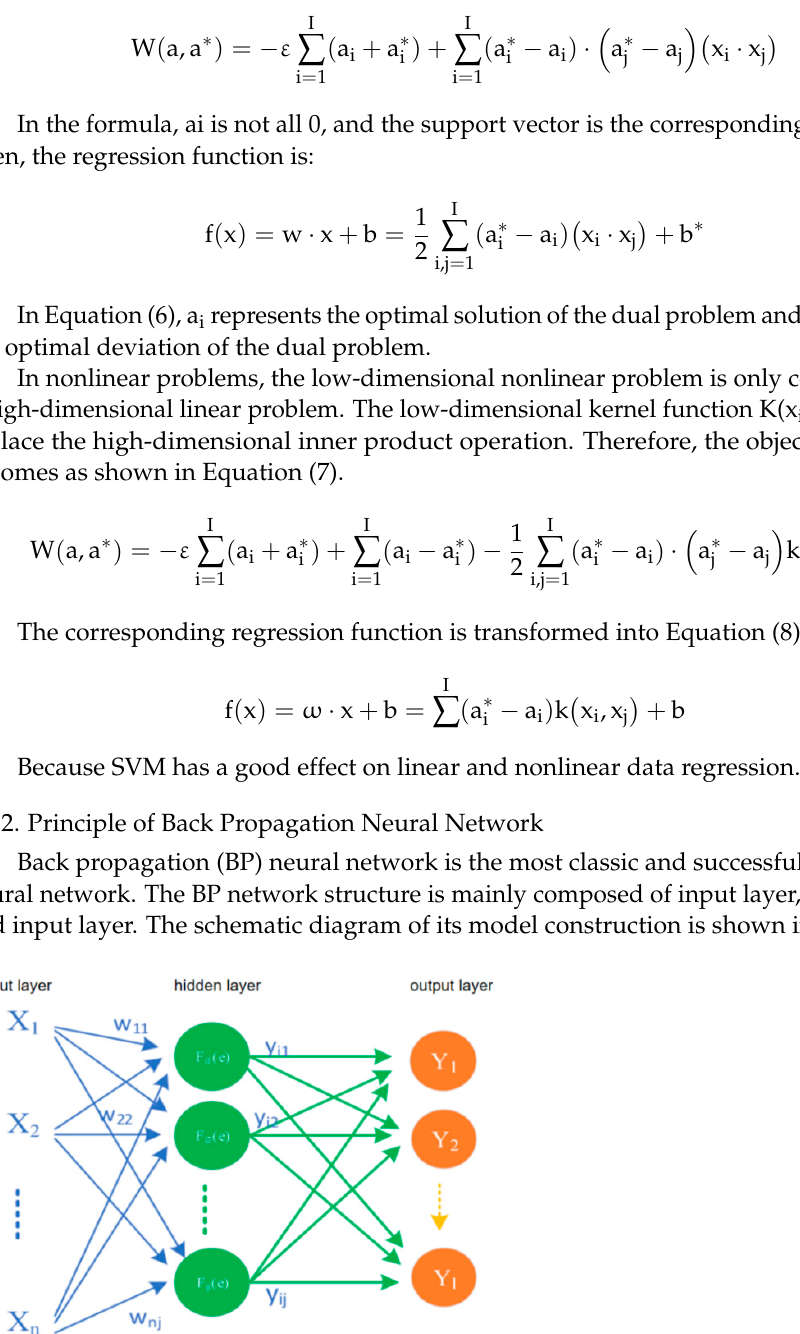
Figure 10. Schematic diagram of b ack p ropagation neuron calculation. Where X and W are shown in Equation (9). [